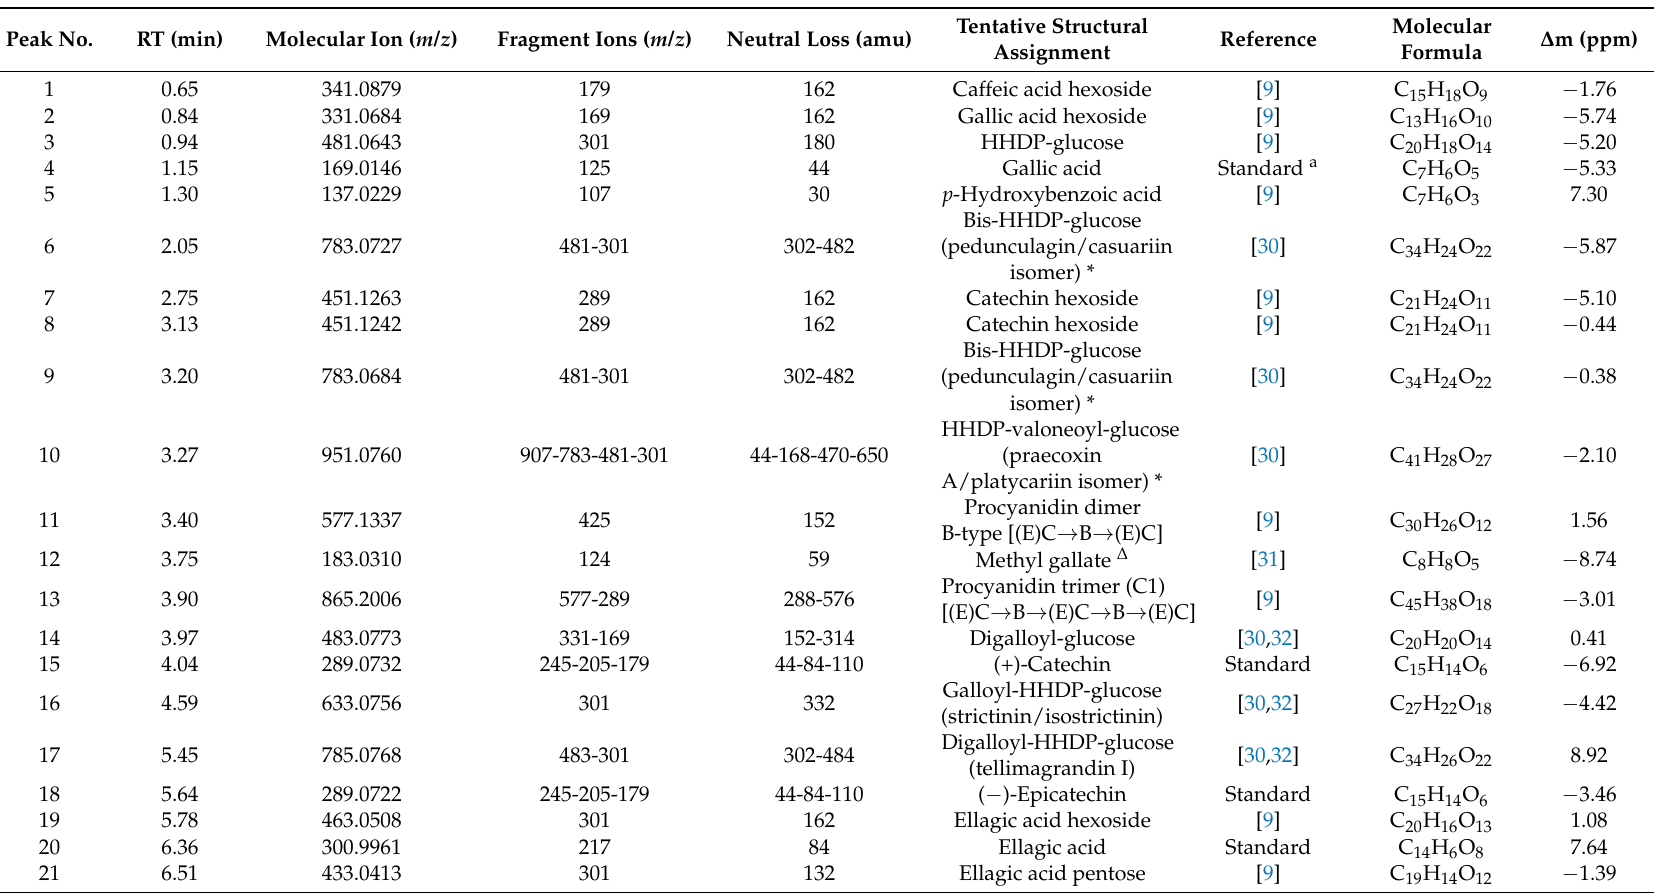
Table 1. Phenolics tentatively identified in mixed pecan kernels